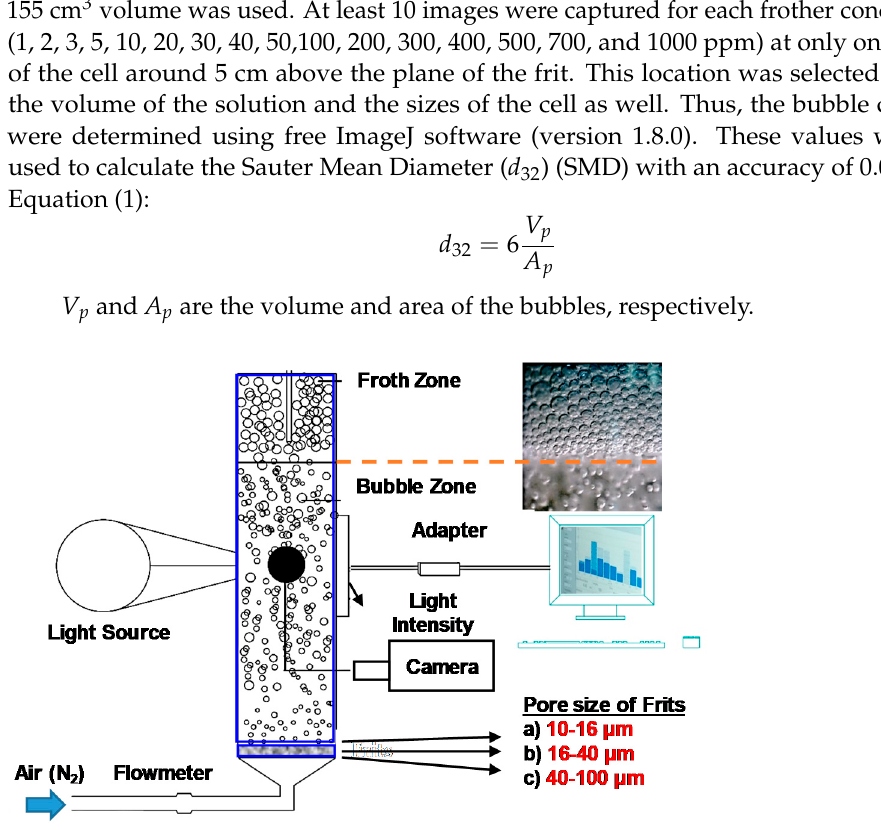
Figure 1. Schematic representation of bubble size measurements (Retrieved from ref. [7] ).